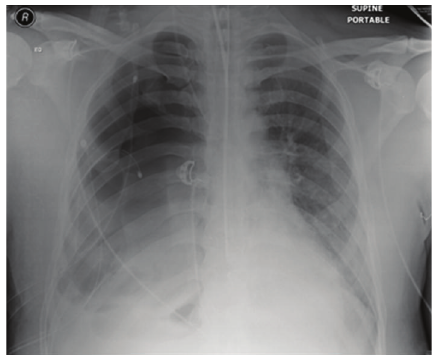
Figure 20: A CXR shows right-sided chest drain tension.